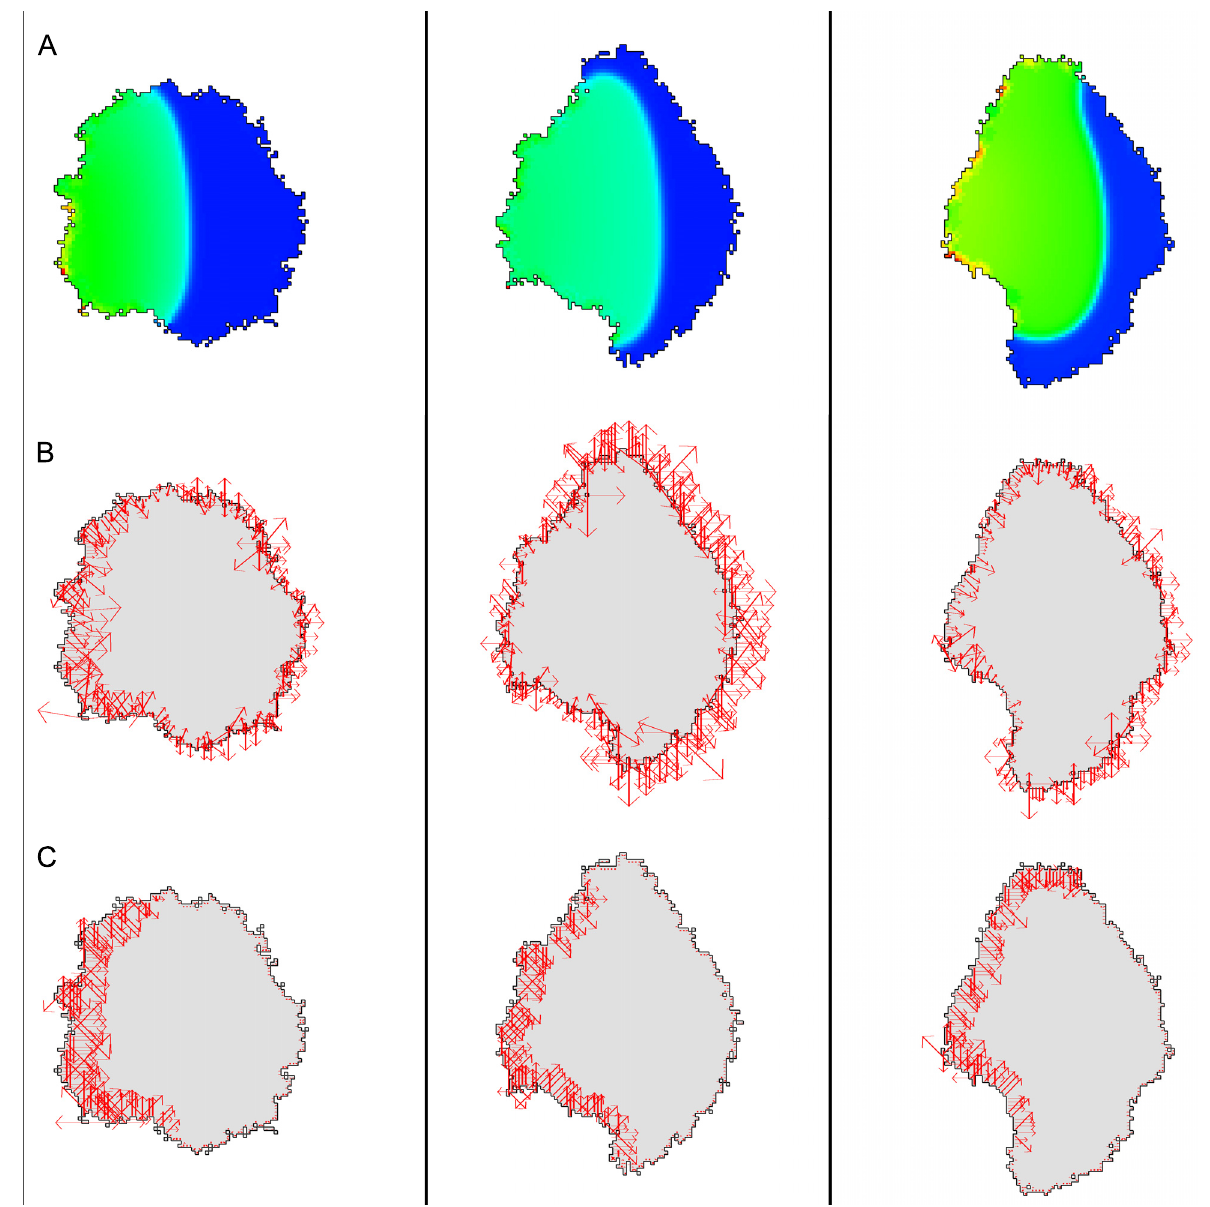
Fig 4. Active contractile forces from internal signaling. Shown is a time sequence (left to right, at 57, 107 and 157 MCS) of a moving cell whose shape changes in response to a polarizing internal signal (e.g. Rho GTPase). (A) The internal GTPase field (bright green at high values) based on the Wave-Pinning model. High levels of activity are assumed to create large local inwards contraction. (B) Total forces given by r H + dH along the u perimeter of the deforming cell. (C) Forces due to the active contraction term ( dH ). Forces are shown without smoothing or interpolation. u Parameter values for CPM were: λ a = 10, a = 4000, λ p = 0, J (0, 1) = 5000, T = 50; parameter values for internal signaling: β = 40 (for dH u ), the numerical redistribution radius was r = 3 (active rho), r = 75 (inactive rho). Parameters for internal reaction-diffusion system, and details for the numerical method are provided in the Supporting Information S1